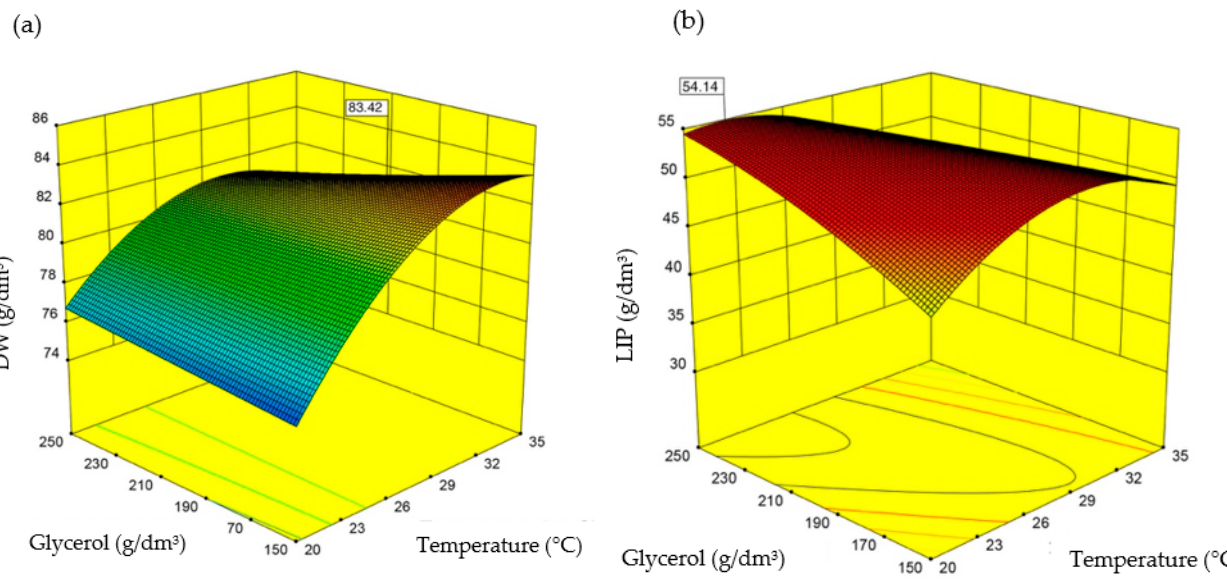
Figure 5. S. limacinum E20 dry weight ( a ) and lipids in the biomass ( b ) as a function of temperature and glycerol levels.